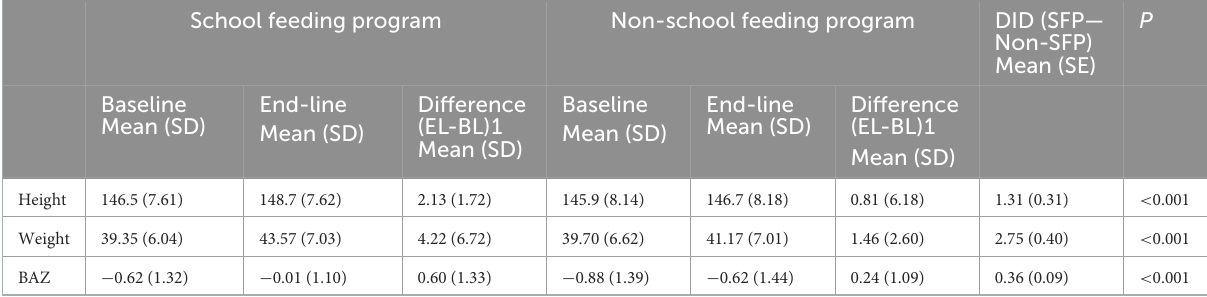
TABLE 2 Differences in differences between baseline and end-line measurements of anthropometric indices among school feeding and non-school feeding groups of adolescents in Addis Ababa and Adama, Central Ethiopia, 2020/2021. School feeding program